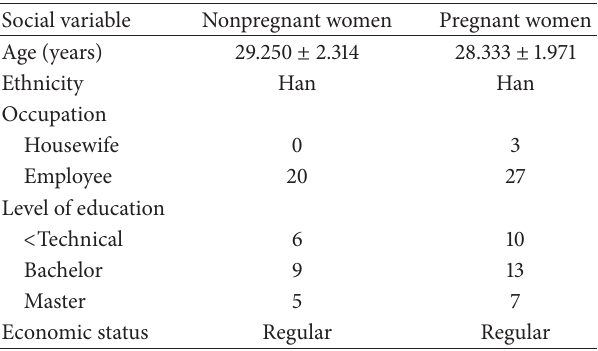
Table 1: Social characteristics of the groups